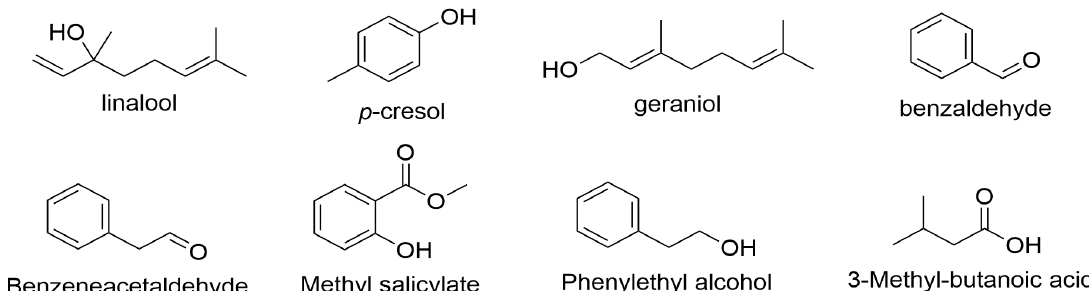
Figure 4. The chemical structures of the eight key active volatile compounds.